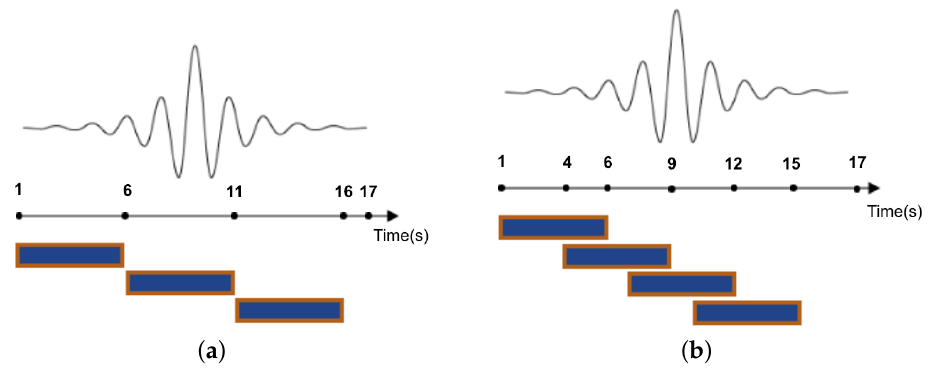
Figure 3. 5 s sliding windows. ( a ) Non-overlapping; ( b ) Overlapping-2 s